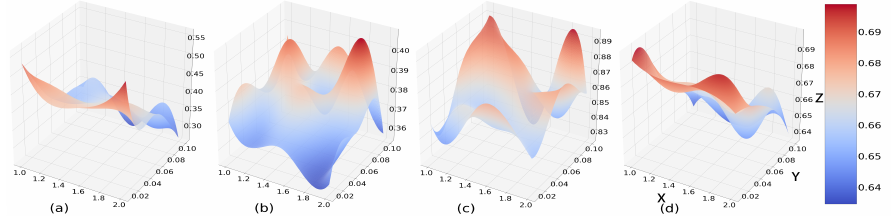
Figure 4. Performance of I-SCE under different parameter settings. The x-axis is s , the y-axis is m , and the z-axis is the accuracy. ( a ) Deepfool attack on MNIST. ( b ) Deepfool attack on CIFAR10. ( c ) Untargeted PGD attack on MNIST. ( d ) Untargeted PGD attack on